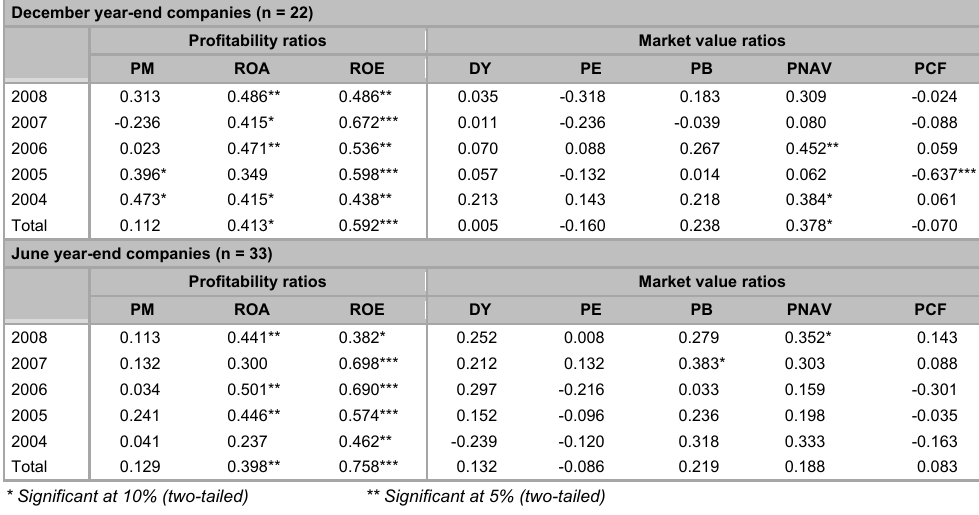
Spearman’s rank-order correlation between technical efficiency and profitability and market value